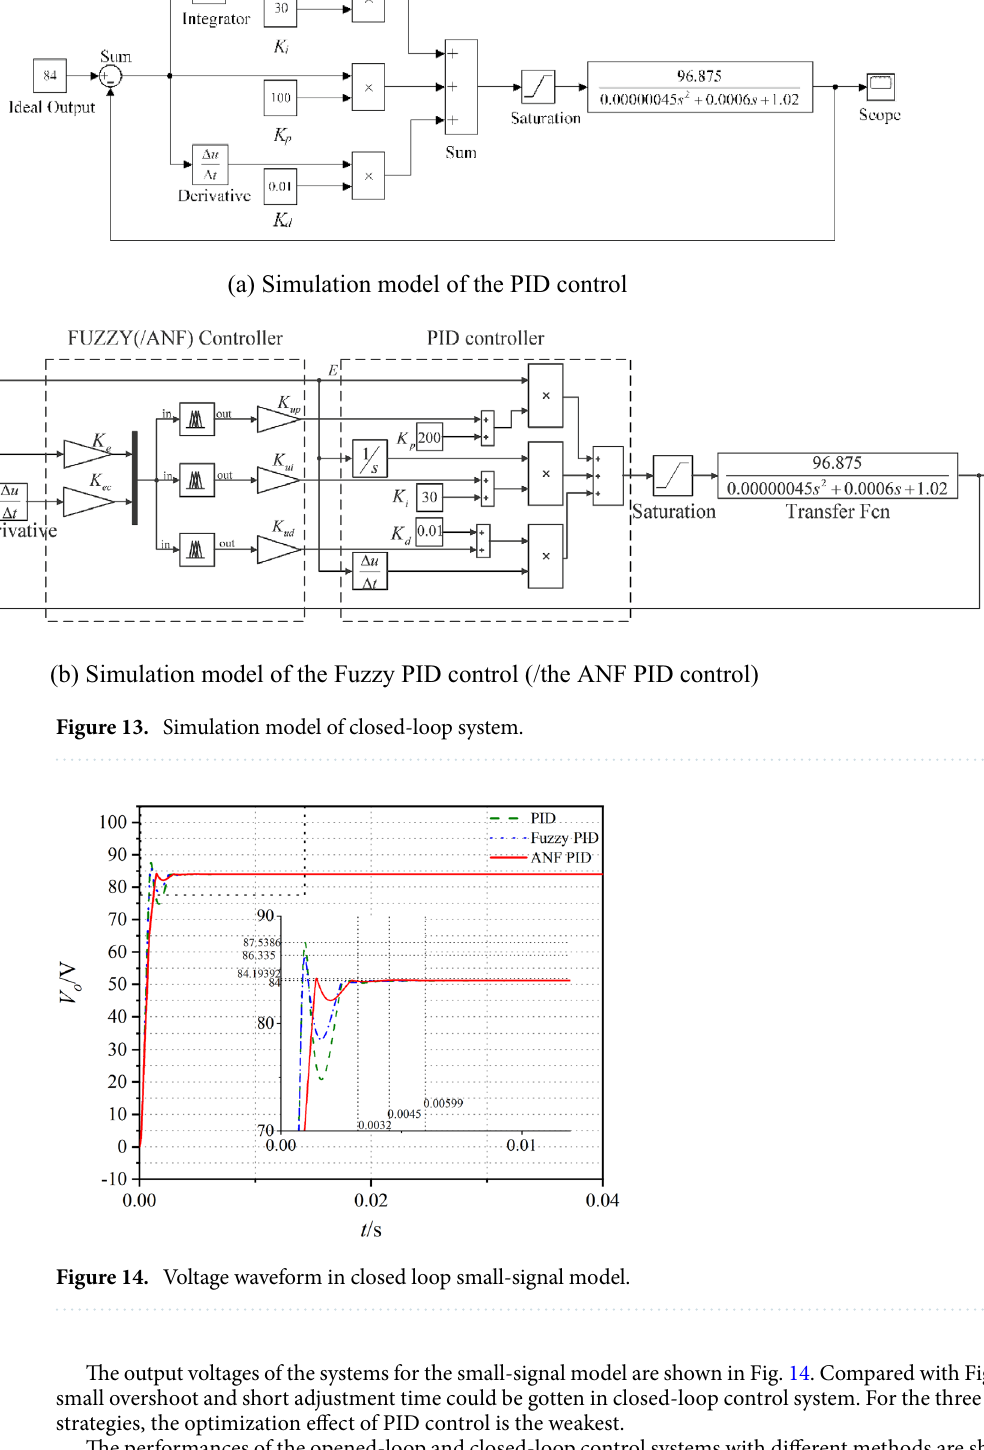
Table 5. To compare the effectivity of the methods, the optimization rate of overshoot G is defined as